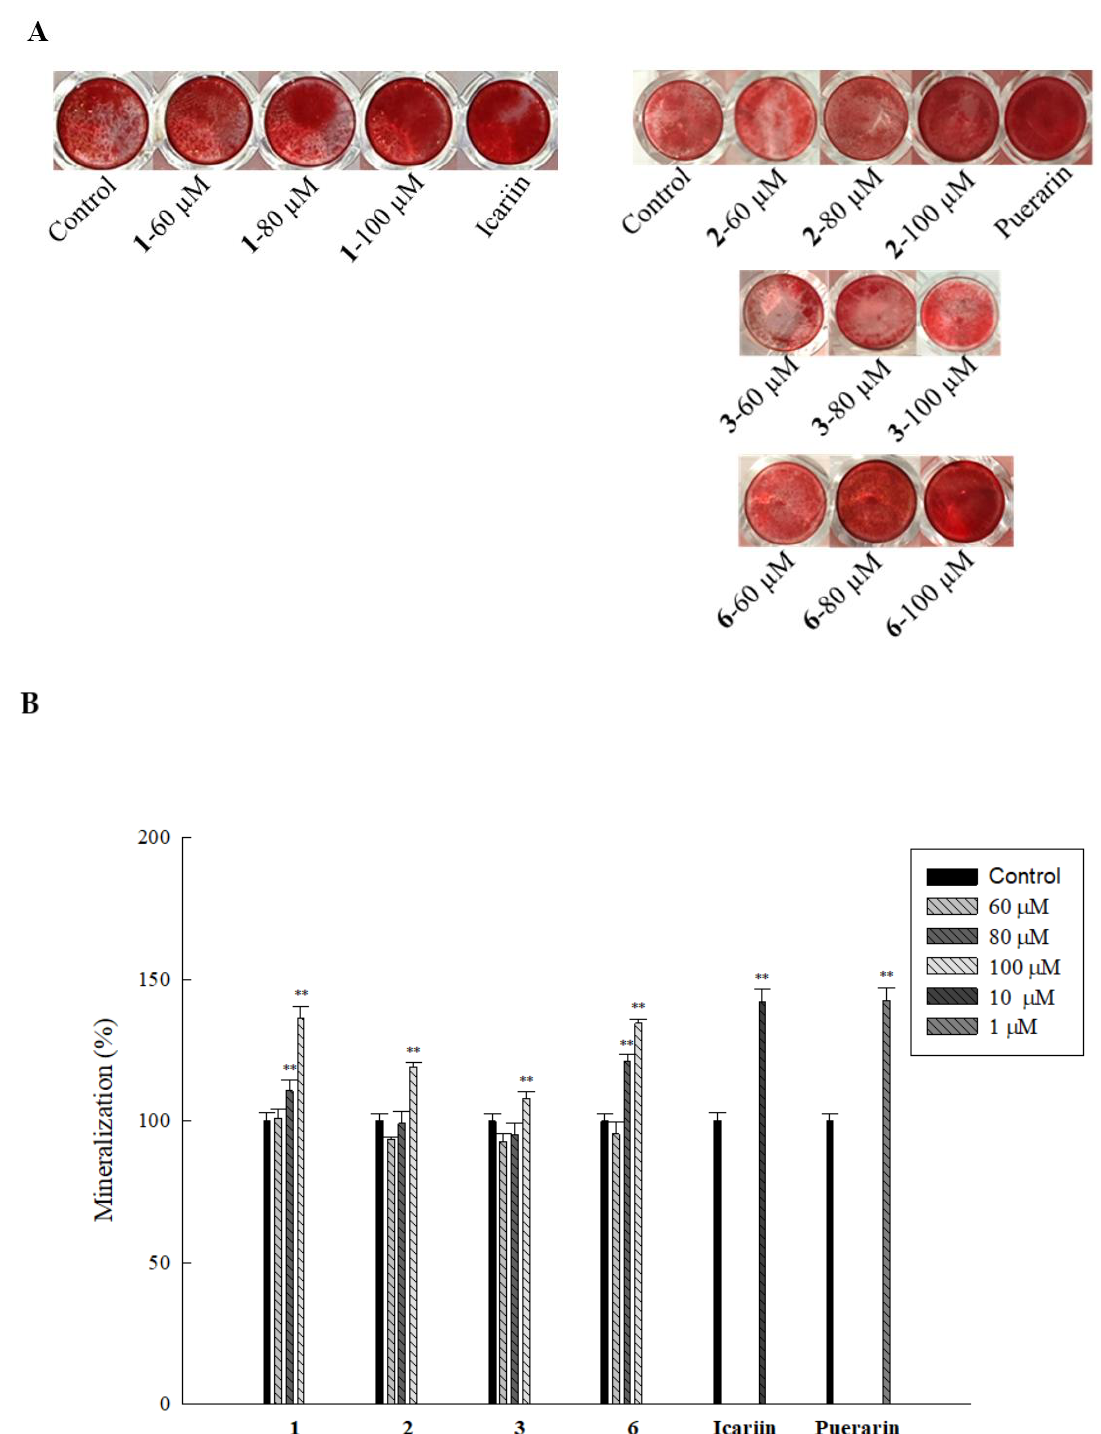
Figure 3. Isolated compounds increase mineralization in HOb cells. Cells were seeded in a 48-well plate for three days, after which fresh osteoblast di ff erentiation media (ODM) miner containing inducers and samples were added. Subsequently, every two days, fresh ODM miner, inducers, and samples were added until the 11th day. Mineralization was then detected by performing an alizarin red assay. ( A ) Pictures show mineral deposition after addition of the alizarin red dye, and ( B ) the graph shows quantitative data obtained after adding 10% cetylpyridinium chloride as a de-stain to dissolve the crystals. Data are expressed as the mean ± SD (** p ≤ 0.01 compared to the control), and all experiments were performed in